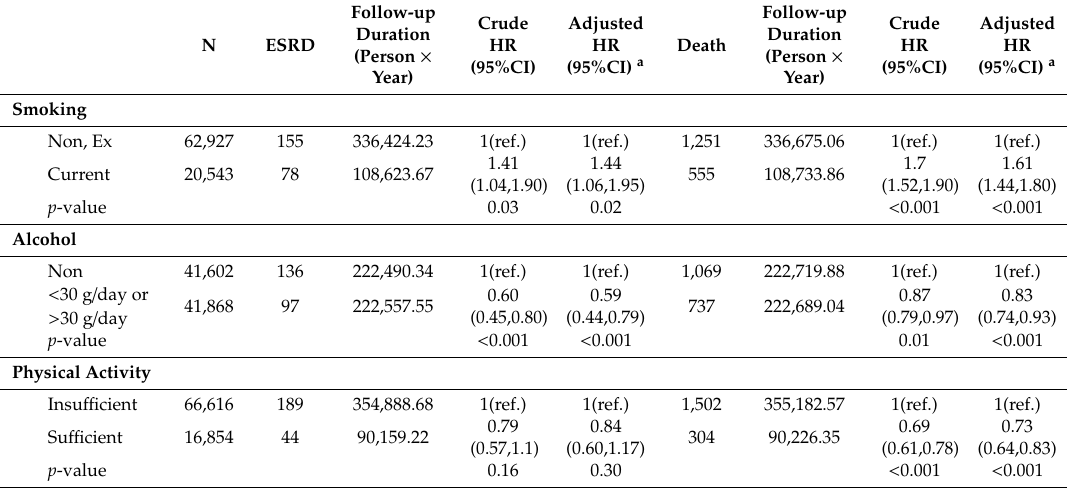
Table 2. Health-related behaviors and risk of ESRD and death.